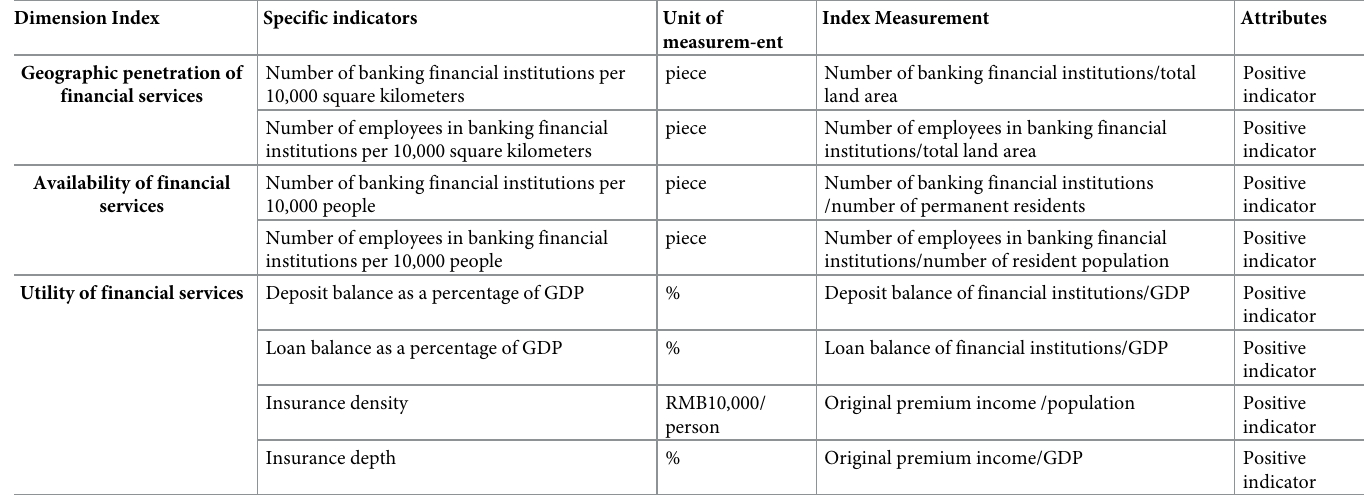
Table 1. Evaluation index system for the development level of inclusive